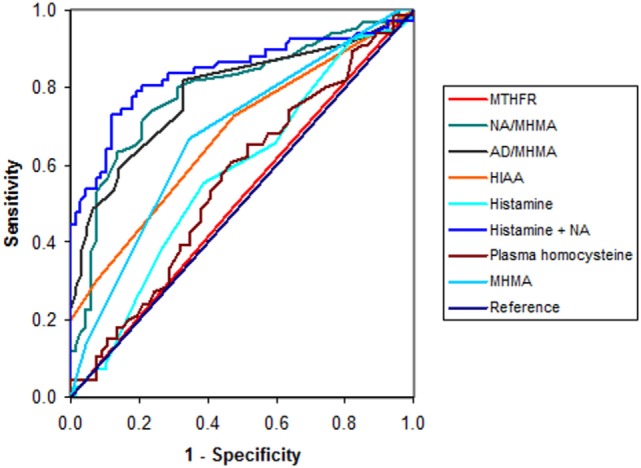
ROC curves for variables residual to the 21 biomarker set.